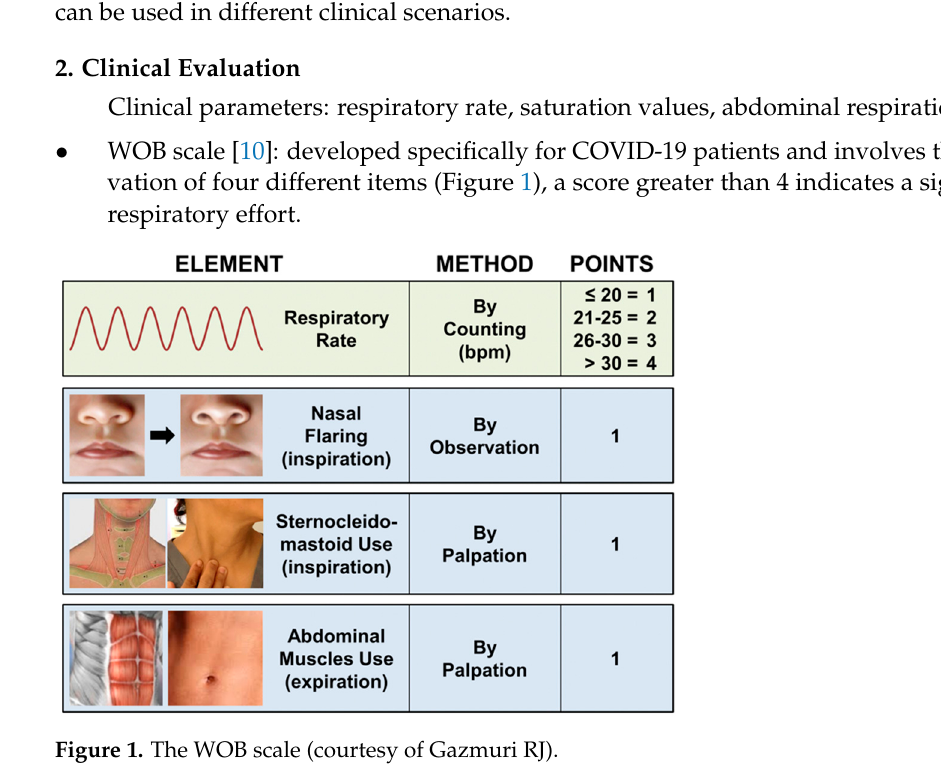
Figure 1. The WOB scale (courtesy of Gazmuri RJ).